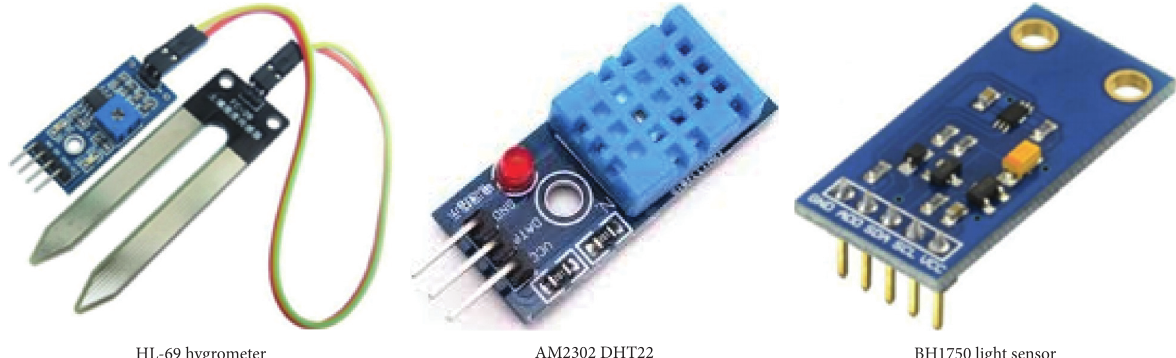
Figure 6: Sensors